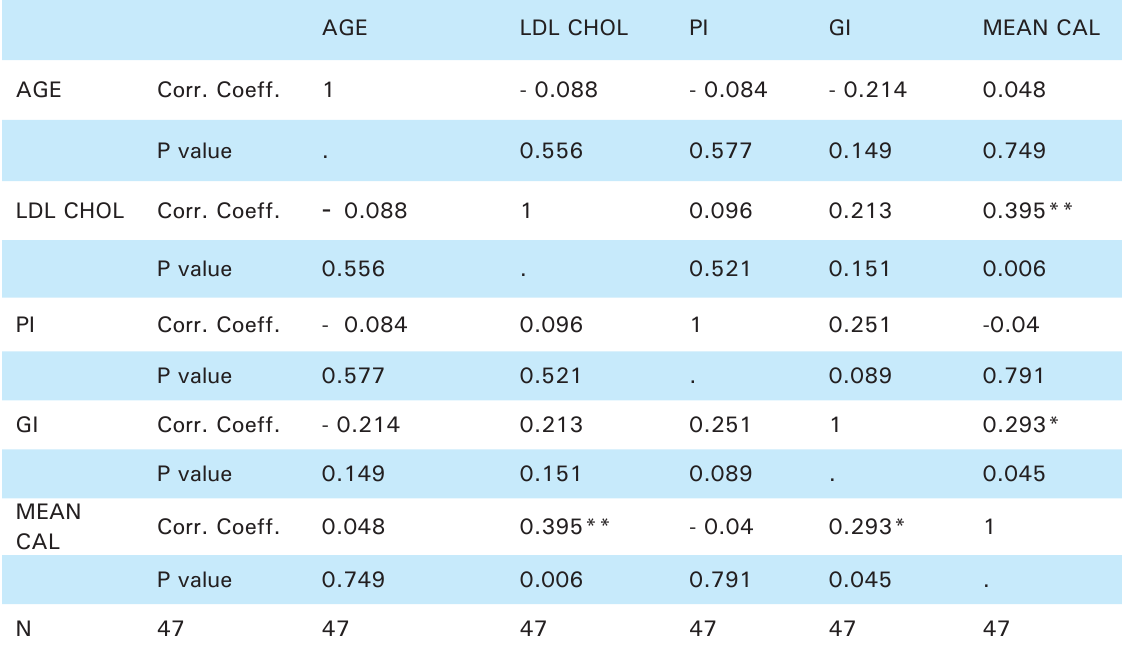
Table 2. Correlation Matrix of Variables under